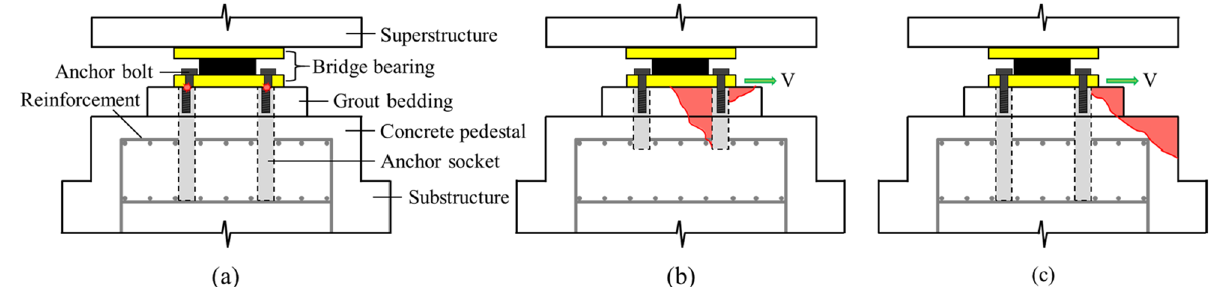
Figure 1. Schematic drawing of bridge bearing anchor and failure modes: ( a ) failure of anchor bolt, ( b ) concrete pryout, ( c ) concrete breakout.